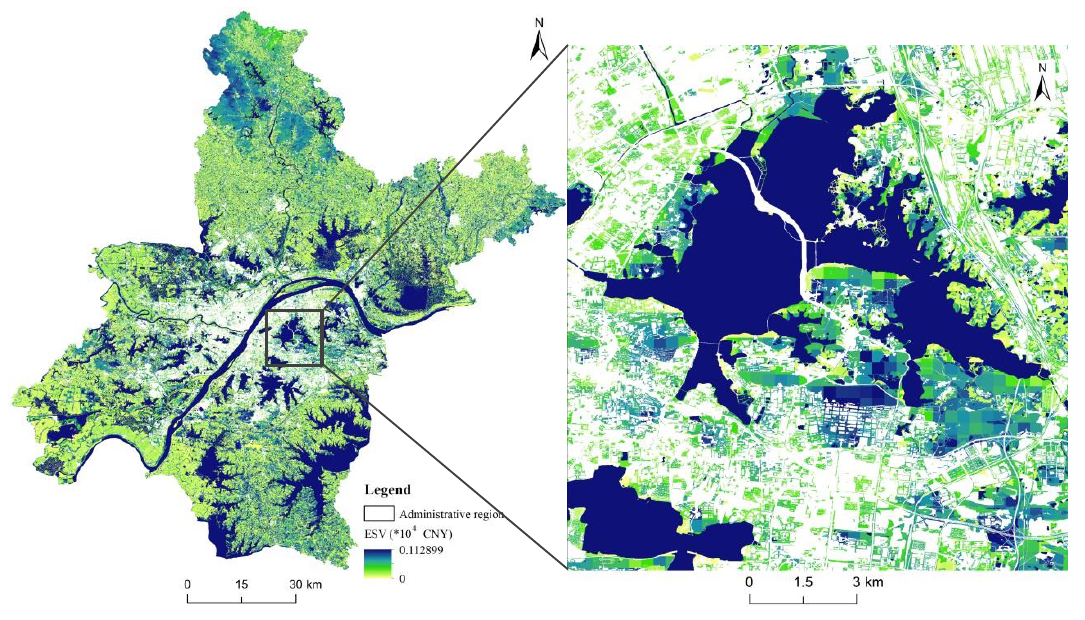
Figure 3. Spatial patterns of ESV and local enlargement (5m*5m grid)